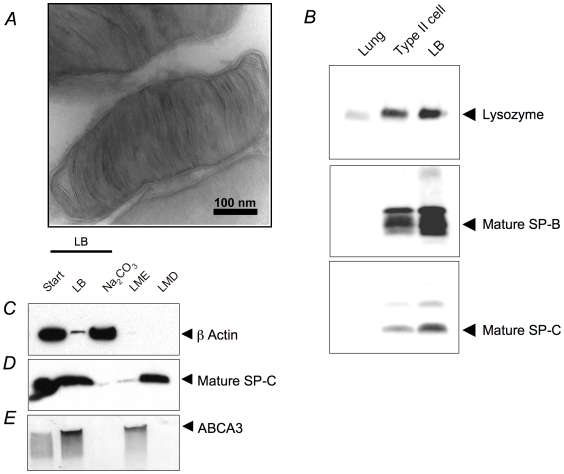
Characteristics of isolated lamellar bodies.(A) Cryo-TEM of LB samples obtained before Na2CO3 stripping or sulfo-NHS-SS-biotin treatment. (B) Enrichment of lysozyme, mature SP-B and mature SP-C during LB isolation. (C–E) The effect of Na2CO3 mediated peripheral protein stripping on LB protein distribution. Start is the initial LB sample, LB is the LB sample after Na2CO3 treatment, Na2CO3 is the Na2CO3 solution after stripping, LME refers to limiting membrane enriched fraction and LMD refers to limiting membrane depleted fraction. (C) β-actin protein, (D) mature SP-C and (E) ABCA3 protein within these fractions. All samples were normalized to total protein content.